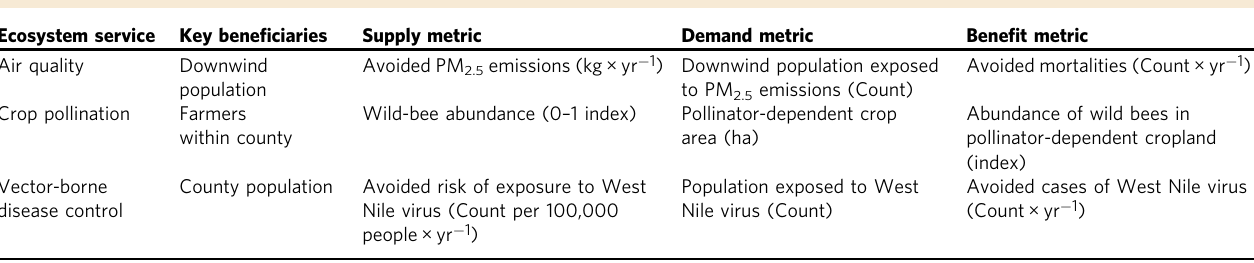
Table 1 Metrics used for estimating ES supply, demand, and bene fi